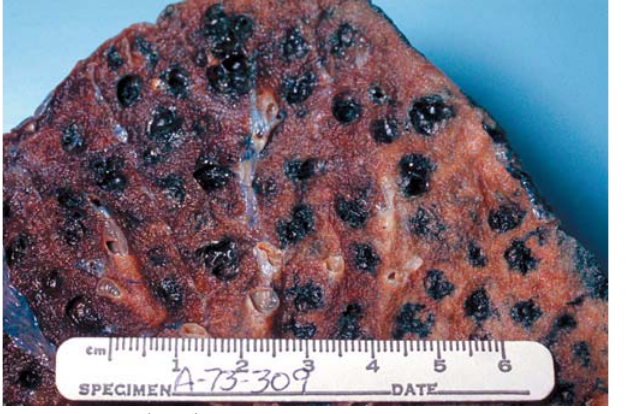
Figure 1. Gross Pathology of the Lung Showing Centrilobular Emphysema Characteristic of Smoking (Photo: Edwin P. Ewing, Jr./Centers for Disease Control and